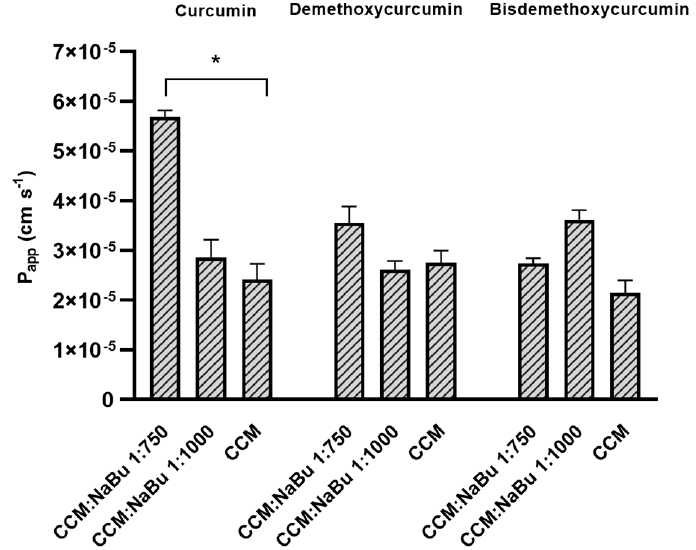
Figure 12. Values of apparent permeability coefficients of curcumin, demethoxycurcumin, and bisdemethoxycurcumin alone and with an addition of NaBu in the molar ratio of 1:750 (20 µM CCM:15 mM NaBu) and 1:1000 (10 µM CCM:10 mM NaBu) determined for permeability through blood-brain barrier. Values are shown as mean ± SEM calculated from three independent experiments. (*) indicates statistically significant differences, p < 0.05.